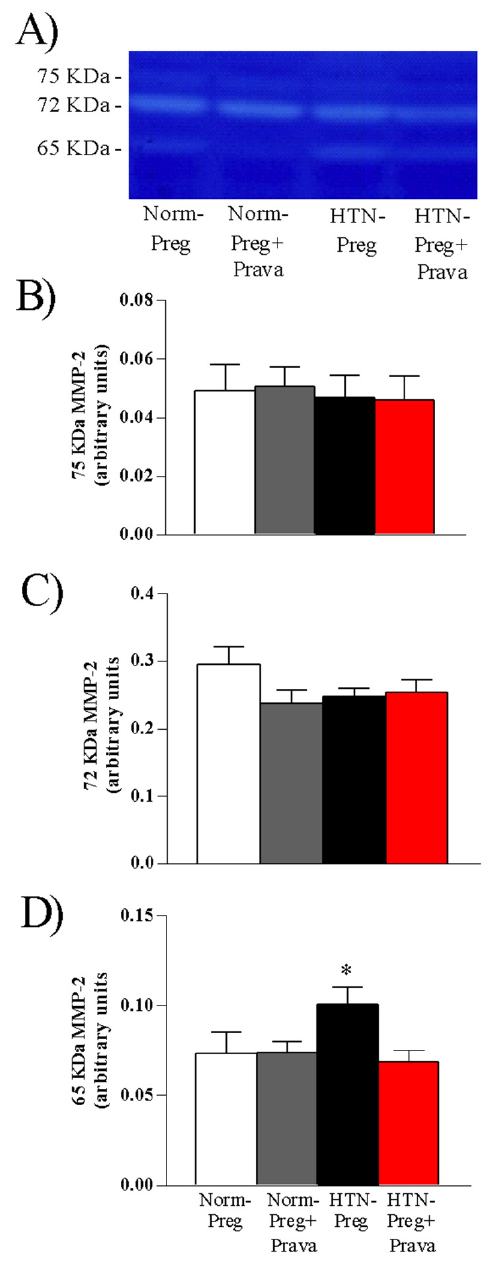
Figure 7. Representative zymography gel of placenta ( A ), gelatinolytic activities of 75 Kda MMP-2 ( B ), 72 Kda MMP-2 ( C ), and 65 KDa MMP-2 ( D ) of Norm-Preg, Norm-Preg + Prava, HTN-Preg, and HTN-Preg + Prava groups. Values represent mean ± SEM. * p < 0.05 vs. Norm-Preg group.